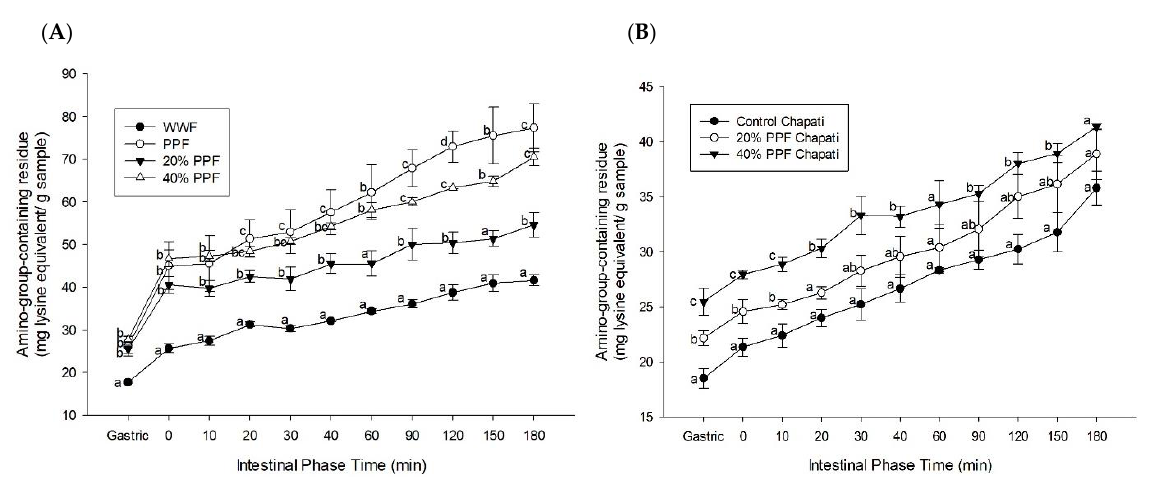
Figure 2. The effects of pigeon pea flour (PPF) and its partial substitution for whole wheat flour (WWF) on amino-group-containing residues equivalent to lysine: ( A ) flour samples; ( B ) chapati samples. The results are expressed as mean ± SEM, n = 3. a–d Different superscript letters for the same time interval denote statistically significant differences in the mean values among the groups at p < 0.05. 20% PPF: 20% pigeon pea flour substitution; 40% PPF: 40% pigeon pea flour substitution.